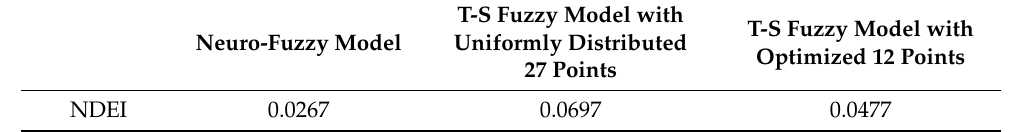
Table 3. NDEIs of the neuro-fuzzy model and T-S fuzzy models. T-S Fuzzy Model with T-S Fuzzy Model with Neuro-Fuzzy Model Uniformly Distributed Optimized 12 27 Points